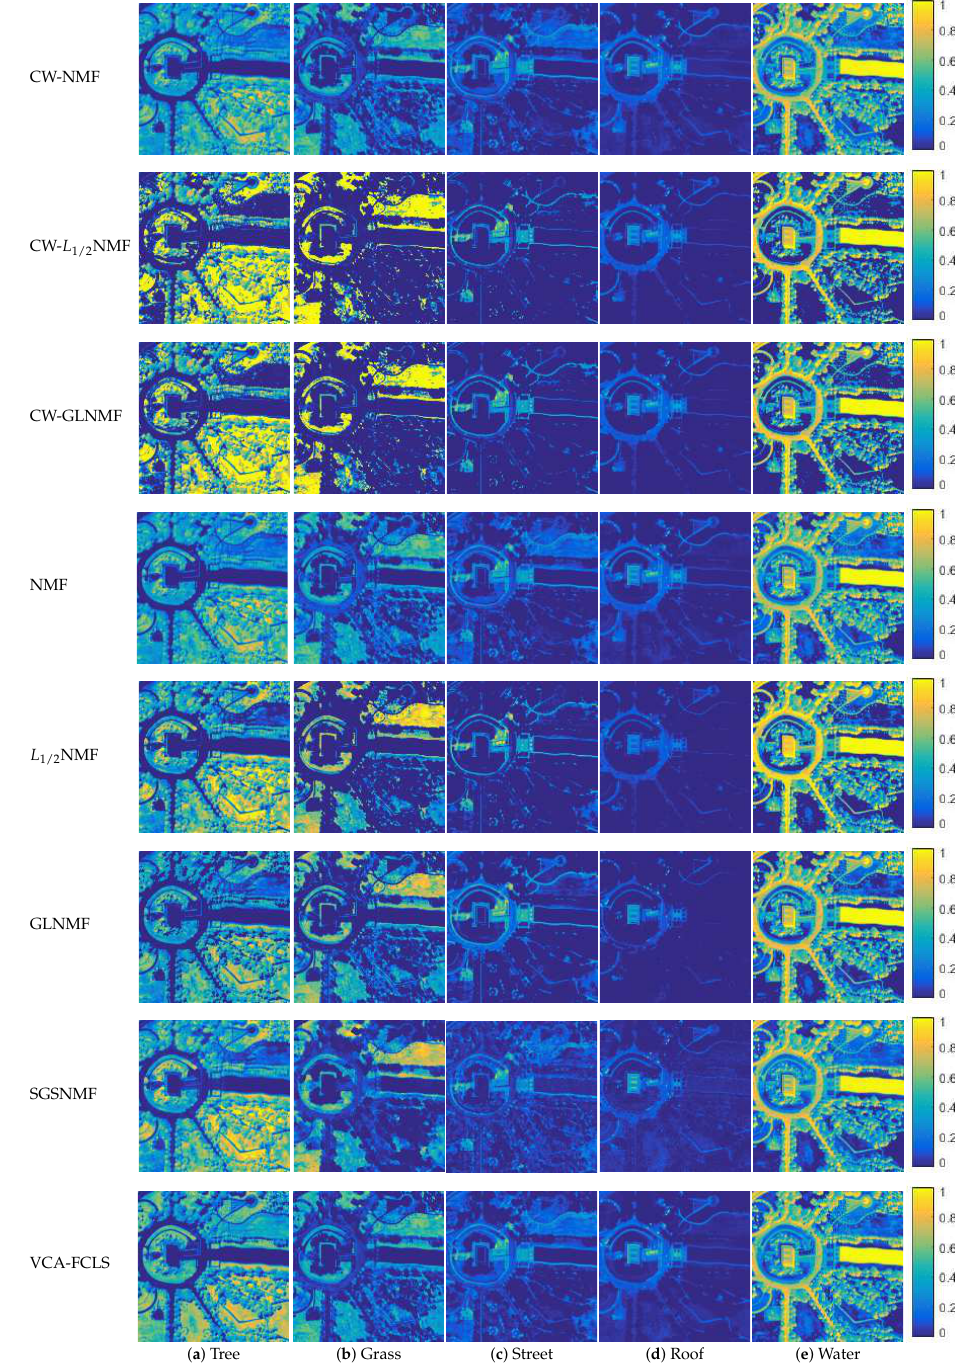
Figure 8. Abundance maps estimated by CW-NMF, CW- L 1/2 NMF, CW-GLNMF, NMF, L 1/2 NMF, GLNMF, SGSNMF, and VCA-FCLS on Washington DC Mall data: ( a ) Tree, ( b ) Grass, ( c ) Street, ( d ) Roof, and ( e )